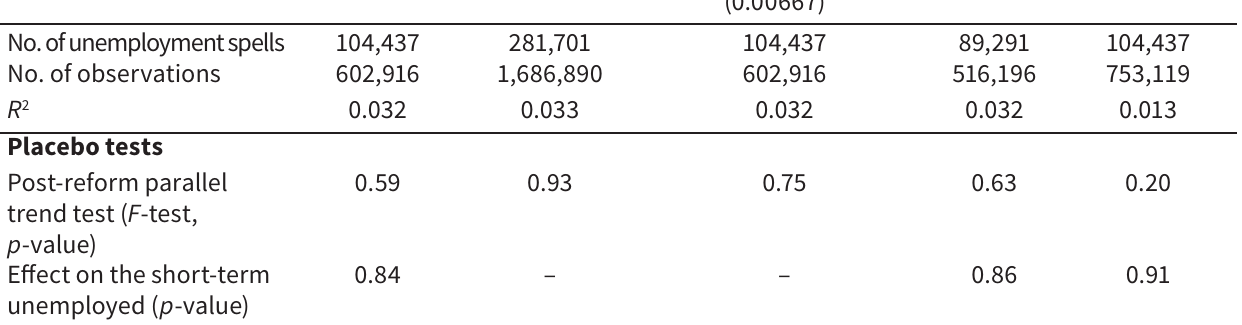
Substitution between the short-term and groups long-term unemployed